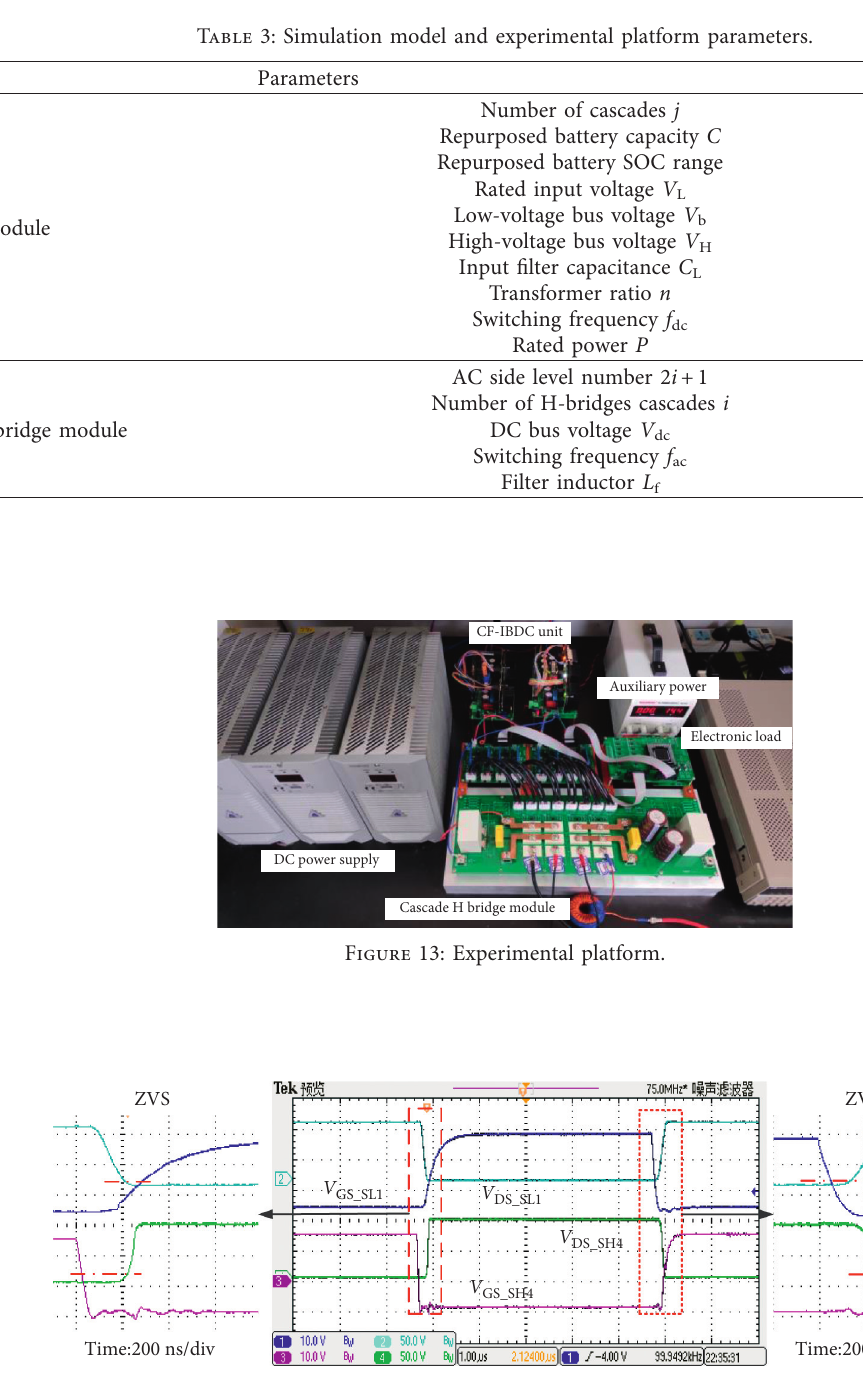
Figure 14: ZVS waveforms at no